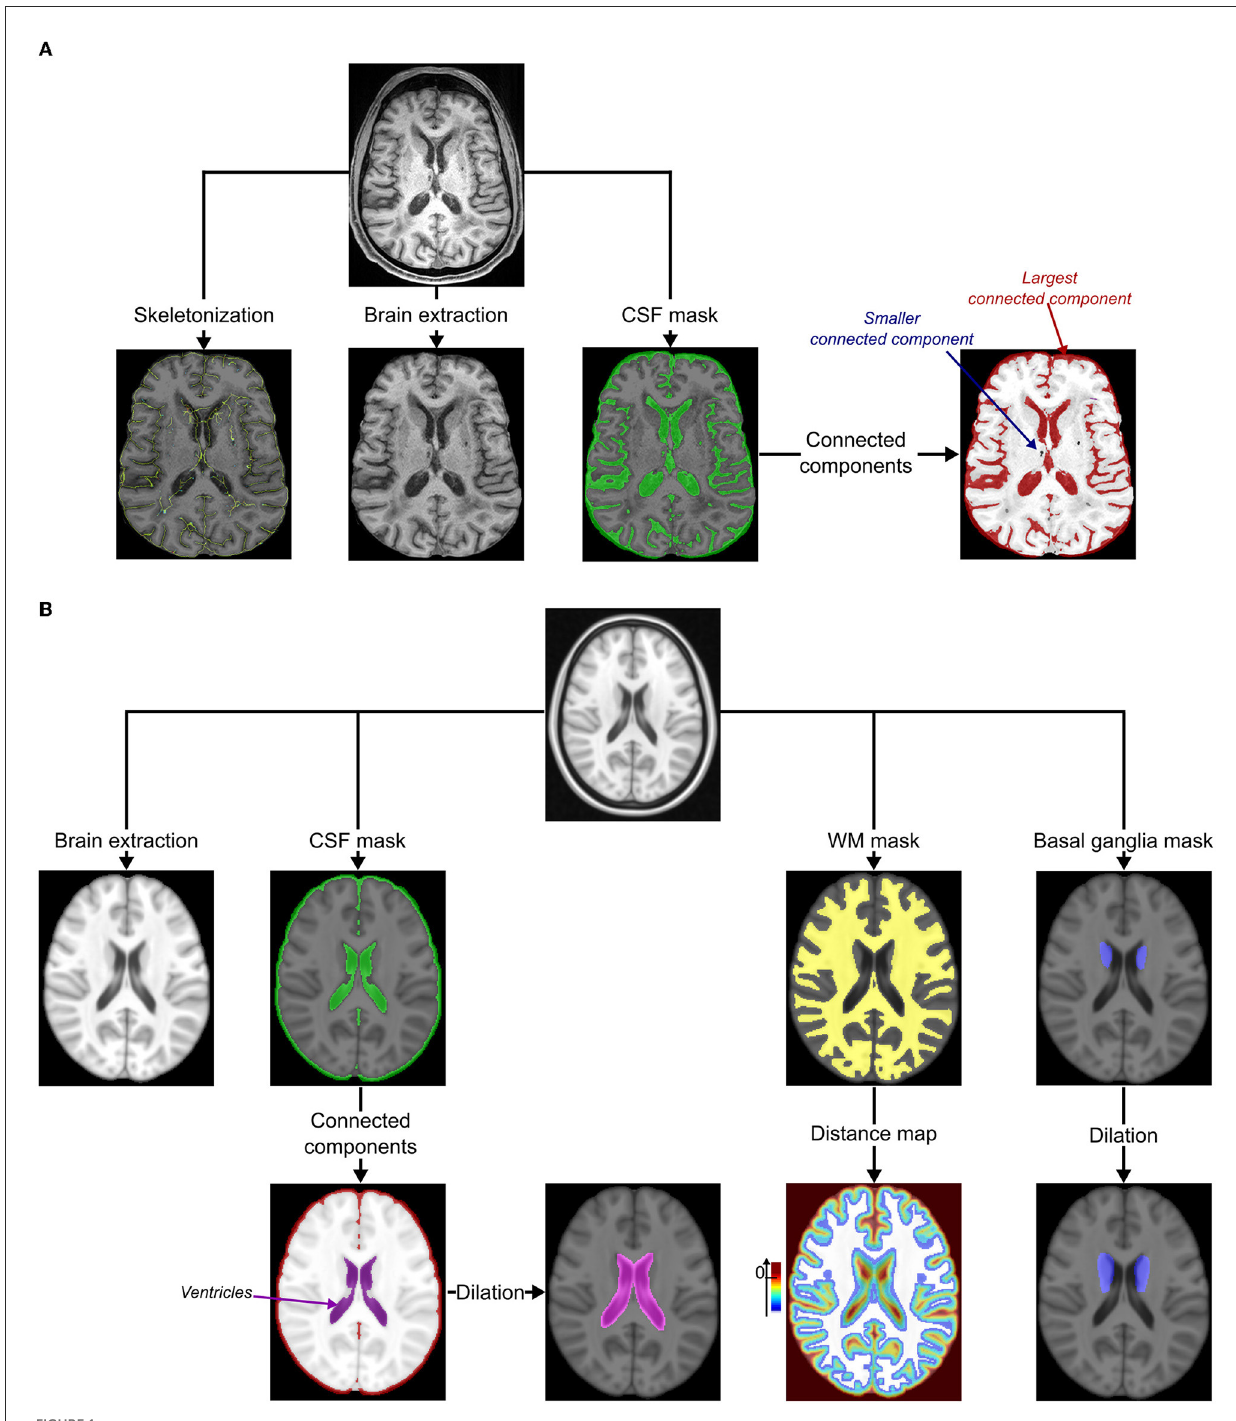
FIGURE1 Pre-processing. (A) Pre-processing of MRIs under study. The cortical sulci were skeletonized using topological and regularization constraints applied to the excrescence of the union of the cerebrospinal fluid (CSF) and the gray matter in the brain (15). The bias of MRI was corrected using the N4 correction procedure (16) and both the brain and CSF masks were extracted using an iterative process based on Bayesian segmentation techniques (17). The connected components of the CSF mask were identified using the ANTs image processing tools (http://stnava.github.io/ANTs/): the largest represented the external CSF (included in the subarachnoid space) connected to ventricles. (B) Pre-processing of the MNI template (18). The bias of the template was first corrected using the N4 correction procedure (16). The brain, the cerebrospinal fluid (CSF), and the white matter (WM, including the major part of basal ganglia) masks were extracted using an iterative process based on Bayesian segmentation techniques ( 16, 17). Connected components of the CSF mask were then identified using ANTs image processing tools (http://stnava.github.io/ANTs/) to easily isolate the ventricles mask visually (not connected to the external CSF in this template). This mask was, then, dilated to keep potential incident lacunes connected to the ventricles of the follow-up (FU) MRI of the subject (kernel of 3 × 3 × 3 voxels). A distance map based on the Maurer distance (19) was also computed from the WM mask to keep only potential incident lacunes within this mask and exclude the most peripheral lesions (exclusion if d ≥ 0mm). A basal ganglia mask was manually delineated by a neuroradiologist (RZ) and dilated to keep potential incident lacunes close to the inner edge of the WM mask (kernel of 3 × 3 × 3